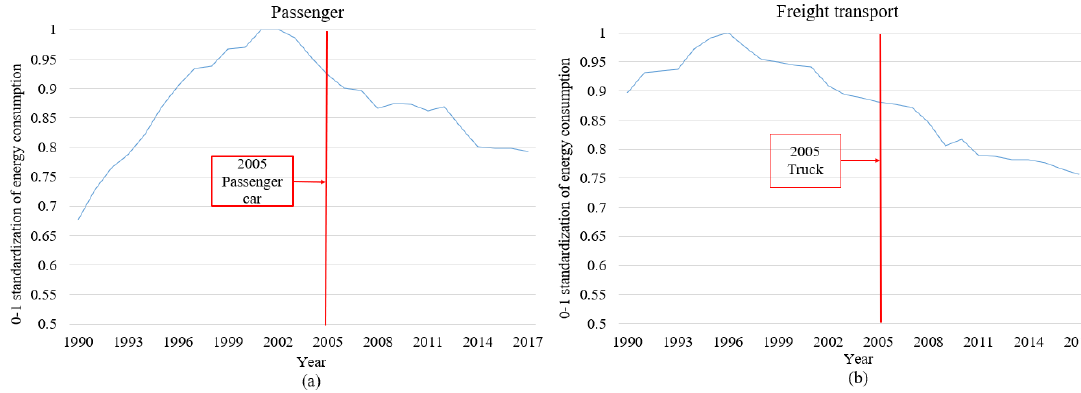
Figure A3. Comparison of different types of energy consumption and the starting time of corresponding policies in transportation (( a ) Passenger and ( b ) Freight transport).